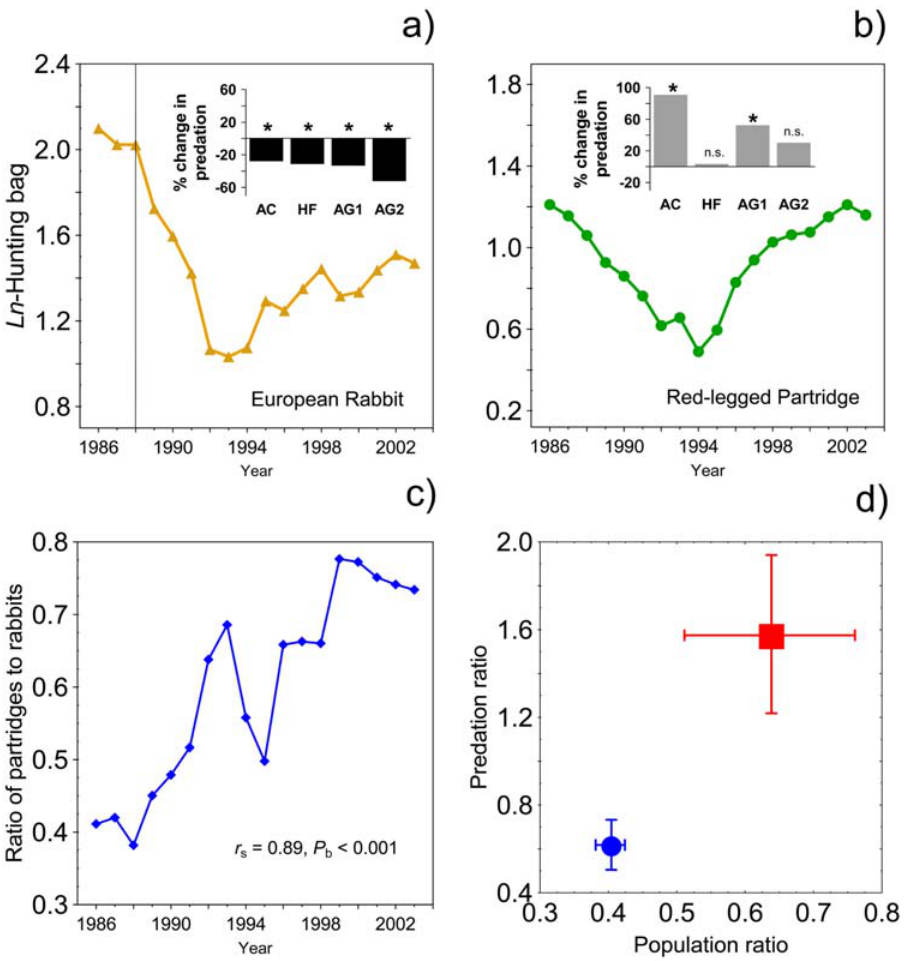
Figure 1. Time series of the log e -transformed hunting bag records for the European rabbit (a) and red-legged partridge (b) in continental Spain, corrected for hunting effort. The vertical line in the figure denotes the temporal location of the RHD outbreak. Within each graph, the small figure shows the change in predation after the RHD outbreak, defined as the percentage shift in the relative abundance of each species in the diet of three major shared predators (see Table S1). * p , 0.05; n.s.=non-significant (according to references given in Table S2). AC represents the golden eagle Aquila chrysaetos ; HF, Bonelli’s eagle Hieraaetus fasciatus ; AG1, northern goshawk Accipiter gentilis in scarcely forested areas; AG2, northern goshawk in heavily forested areas; c) Temporal evolution of the ratio of partridge to rabbits hunted in continental Spain ( r s =Spearman’s rank order correlation; P b =bootstrapped P -value, constructed using 1000 samples); d) The average population ratio of partridges to rabbits during the pre-outbreak (blue circles) and post-outbreak phases (red squares), is plotted against the average ratio of partridges to rabbits in the diet of predators prior and after the outbreak. This latter ratio was weighted by the absolute proportion of partridges and rabbits in the diet of each